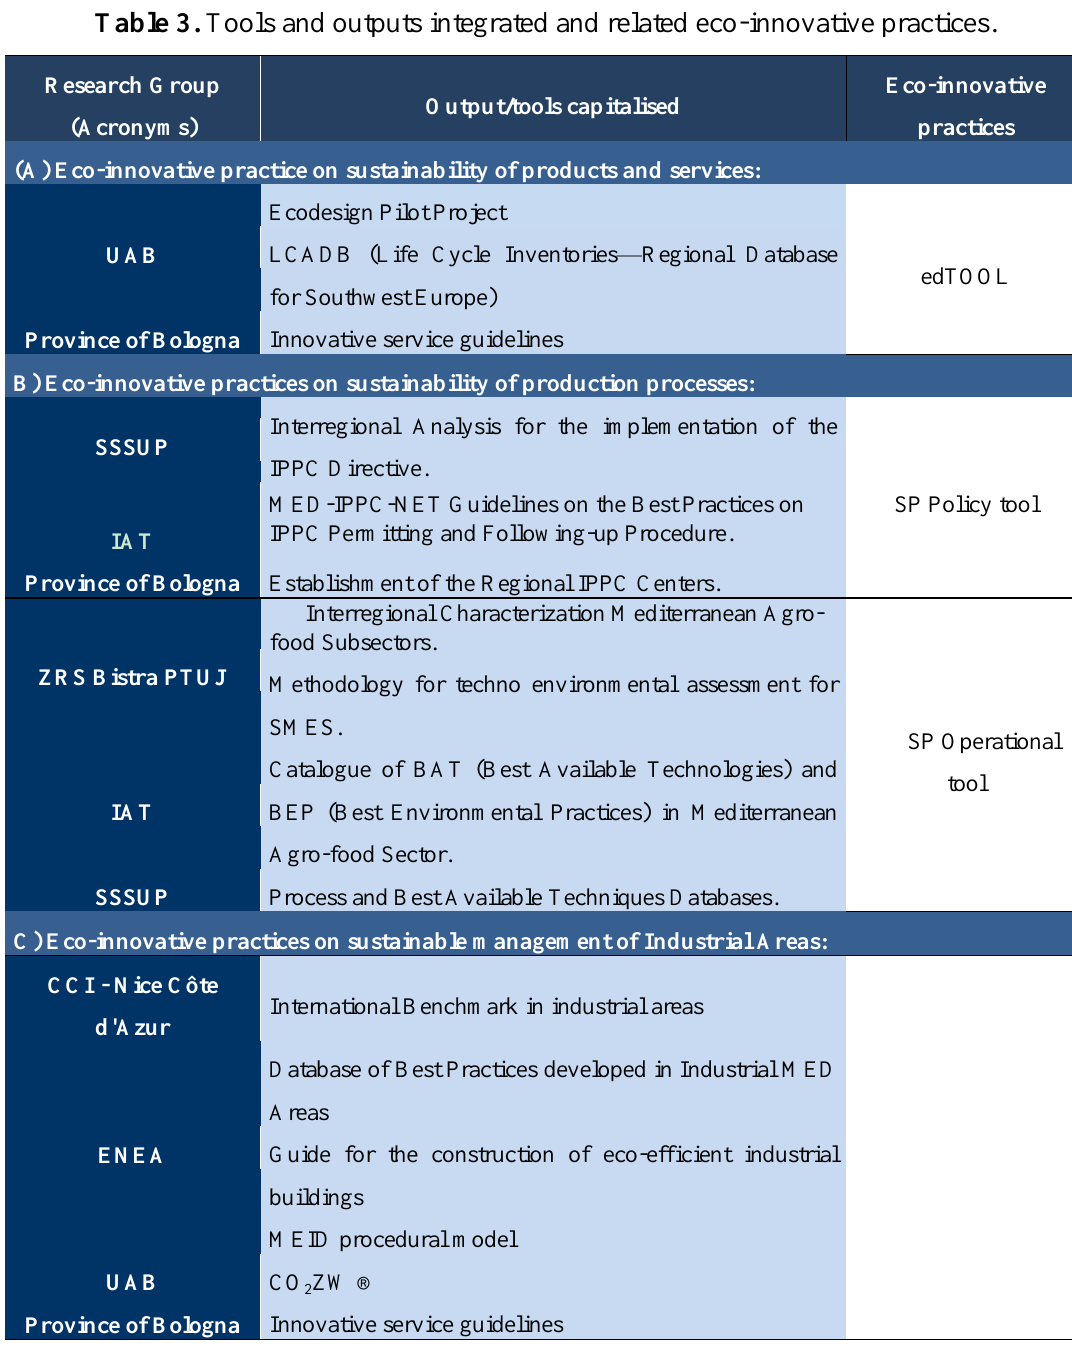
Table 3. Tools and outputs integrated and related eco-innovative